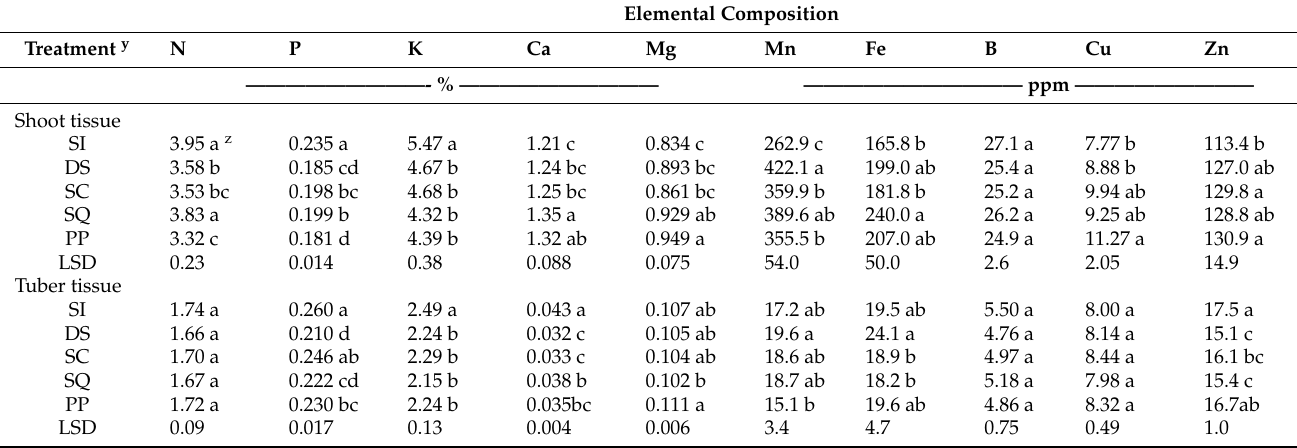
Table 7. Effect of different cropping systems on shoot tissue elemental composition (2008 data). Elemental